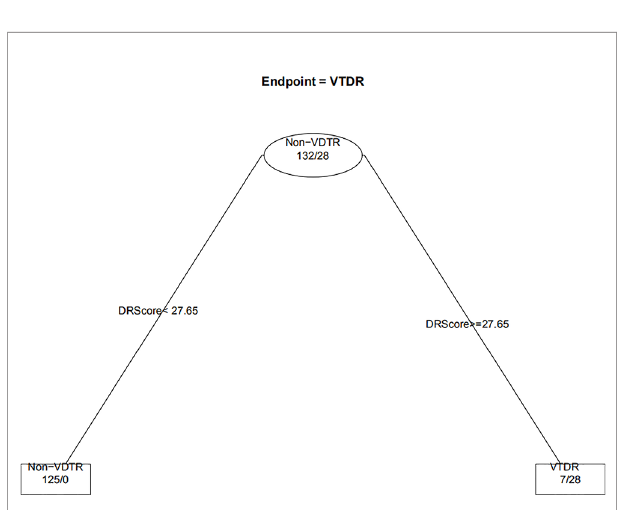
FIGURE 7 | Decision tree for detecting VTDR using only DR